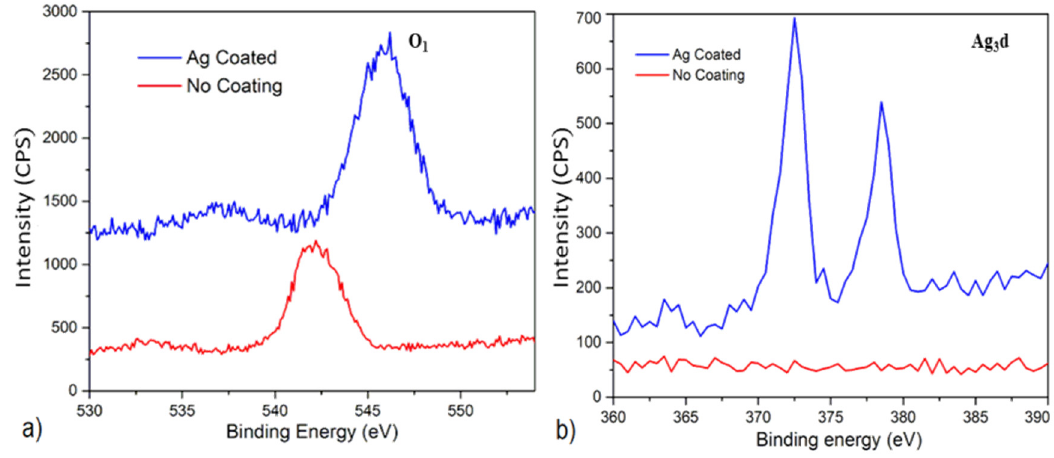
Figure 11. XPS spectrum for ( a ) oxygen and ( b ) silver, on surface of Ag-coated and virgin pellets